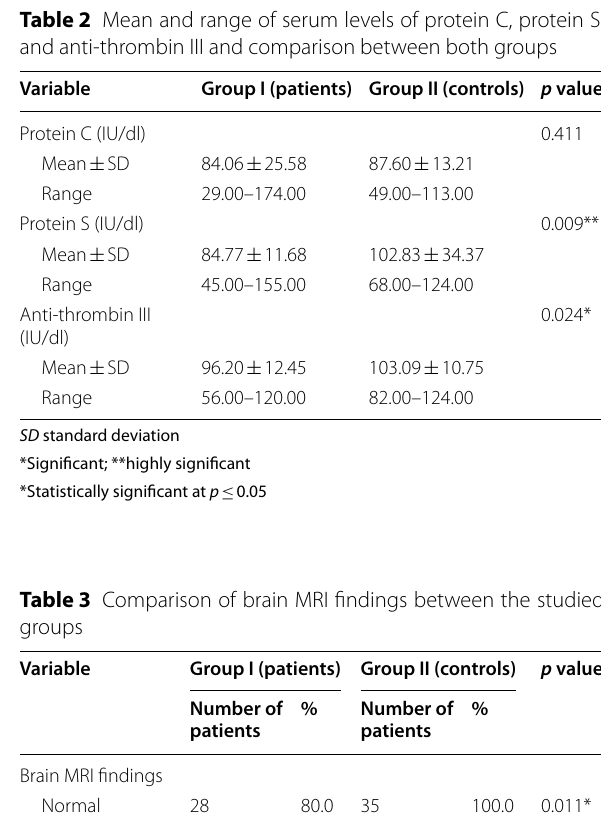
Table 4 Comparison of serum levels of protein C, protein S and anti-thrombin III between migraine patients with and without aura